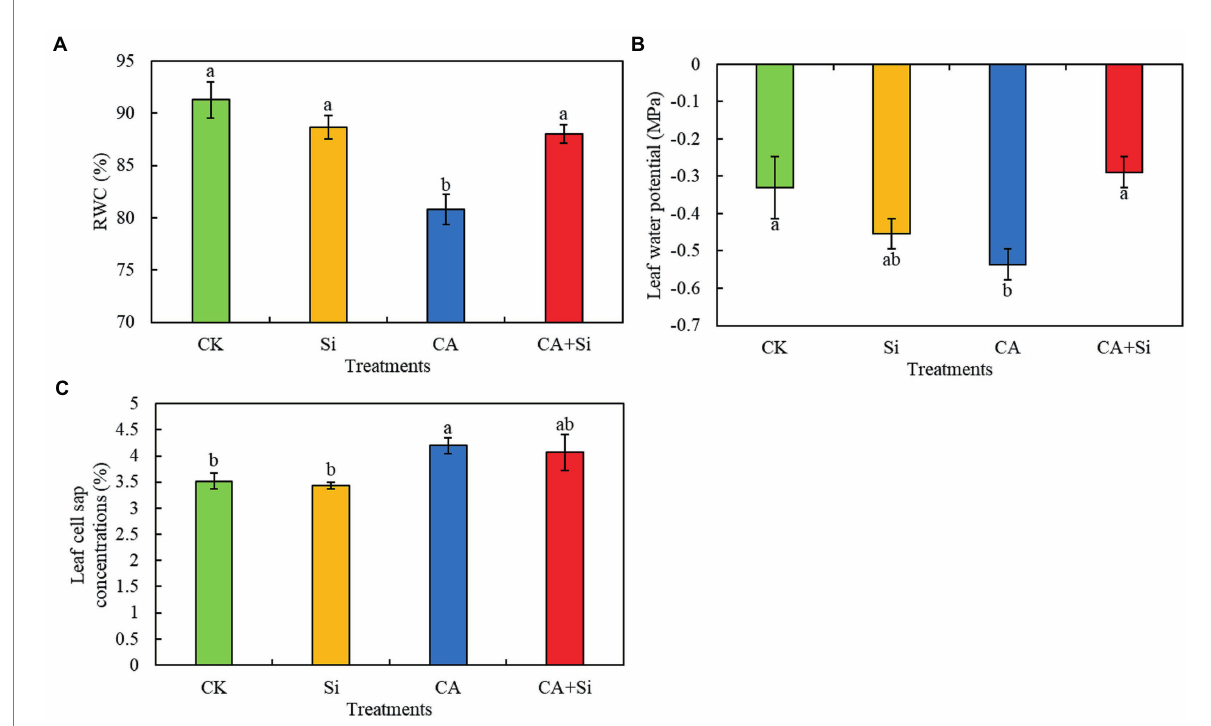
FIGURE 1 Effect of exogenous Si on the relative water content (RWC; A ), water potential (B) , and cell sap concentration (C) of leaves in cucumber seedlings under cinnamic acid-induced autotoxicity stress. Vertical bars represent the mean ± SE from three independent replicates (Each replicate contains three leaves). Different lowercase letters indicate significant differences according to Duncan’s multiple range test ( p <